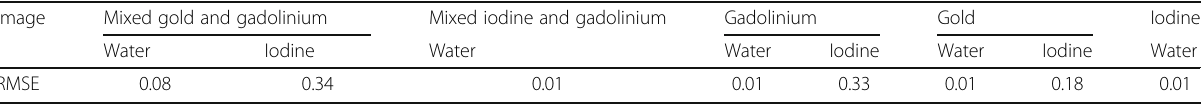
Table 3 Root mean square error (RMSE) coefficients of water and iodine reconstructed images from the different unmixed and mixed solutions Image